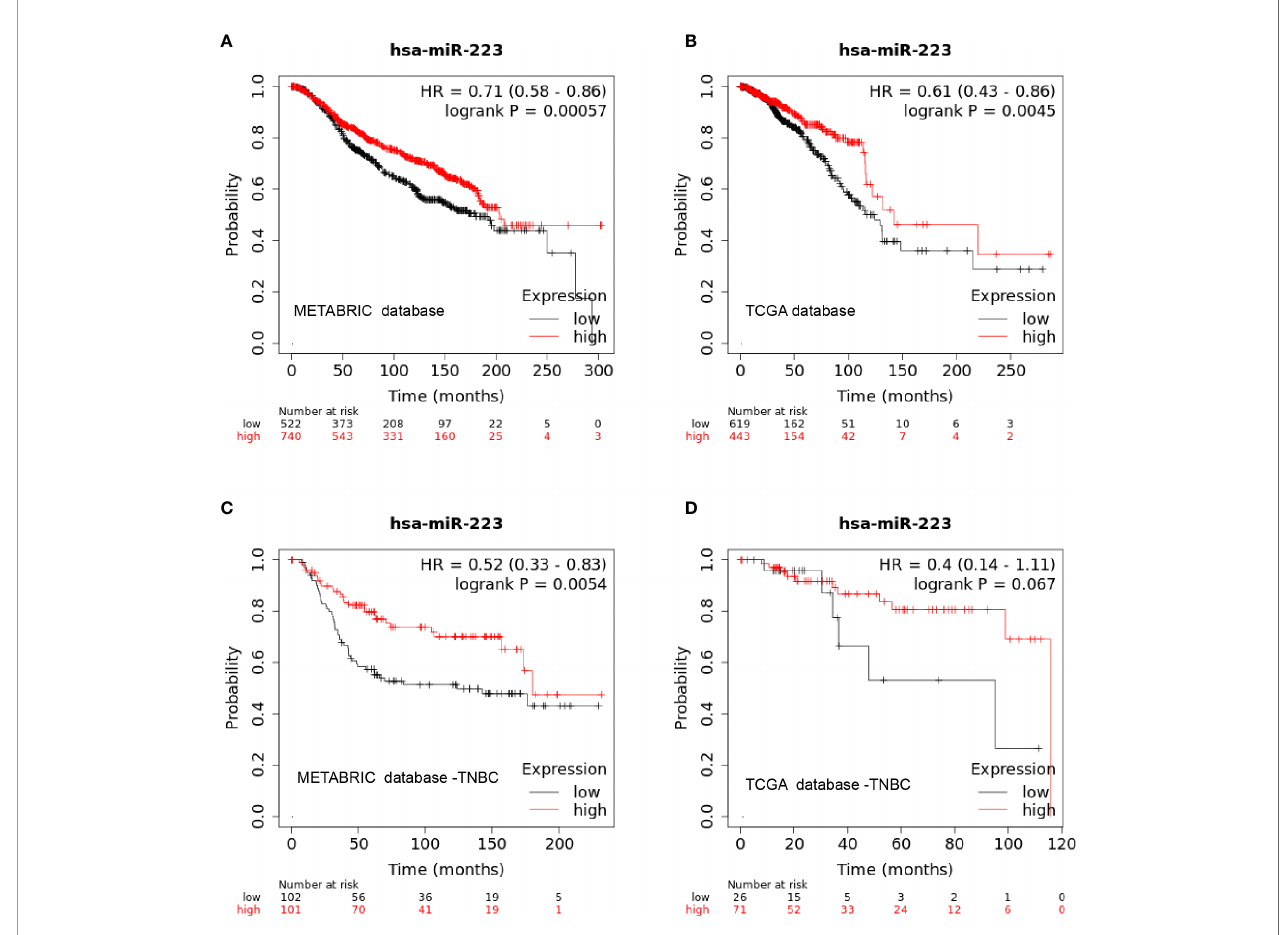
FIGURE 3 | Kaplan-Meier curve of miR-223 expression in the METABRIC and TCGA databases. (A) overall survival in the METABRIC database; (B) overall survival in the TCGA database; (C) overall survival of triple-negative breast cancer patients in the METABRIC database; (D) overall survival of triple-negative breast cancer patients in the TCGA